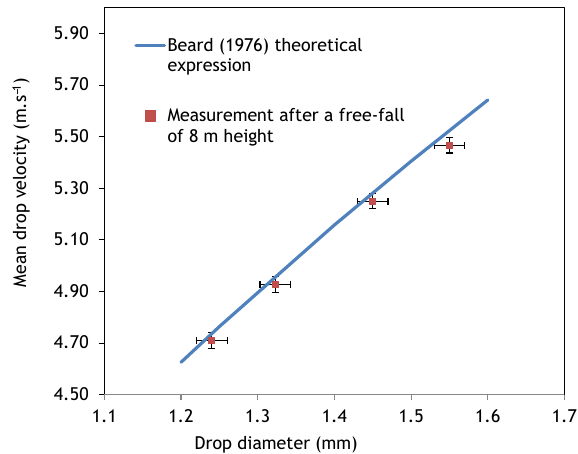
Figure 6. Comparison of axis ratios measured in BERGAME with the model of Beard and Chuang (1987).